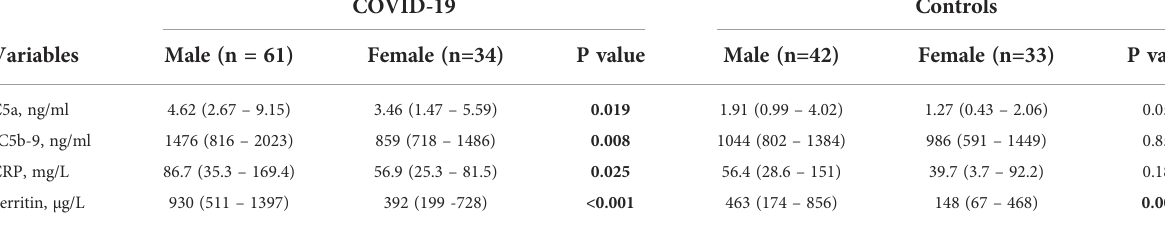
TABLE 5 Sex differences of complement activation and in fl ammatory markers in COVID-19 inpatients vs. controls on